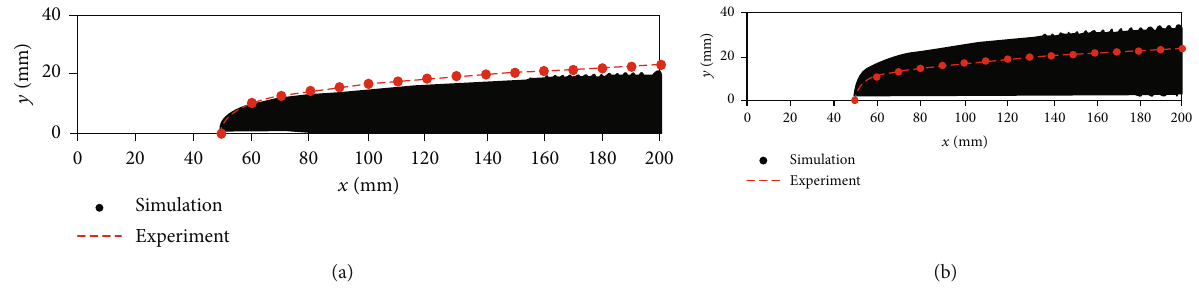
Figure 6: Comparison of spray penetration height with experimental results in the central plane: (a) turbulent and (b) laminar.